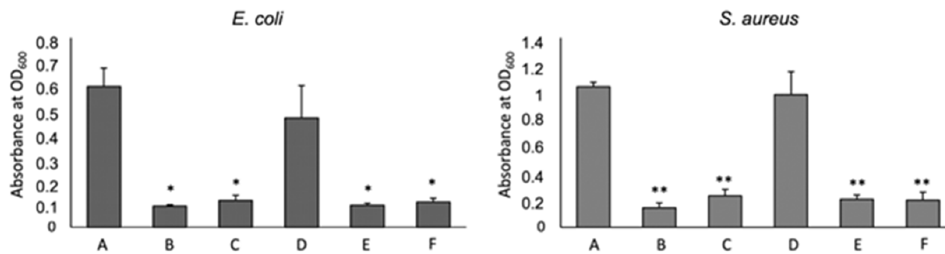
Figure 8. Effect of Chitosan (CS) and Gallic Acid (GA) on bacterial growth. A: non treated, B: HL-3D chitosan-GA 1 mg/mL, C: HL-3D chitosan-GA 0.5 mg/mL, D: CS 10 mg/mL, E: GA 1 mg/mL, F: GA 0.5 mg/mL. The mean ± SD for at least four replicates is shown. Statistical significances between treated bacteria versus untreated * p < 0.001, ** p < 0.0001.